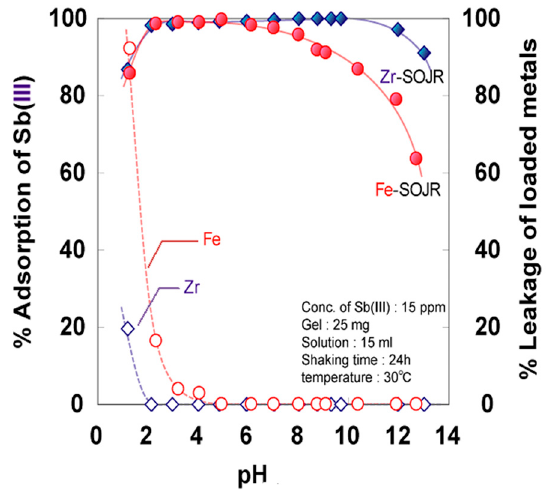
Figure 26. Effect of the equilibrium pH on Sb(III) adsorption by the Fe(III)- and Zr(IV)-loaded SOJR and on leakage of the loaded metal ions.